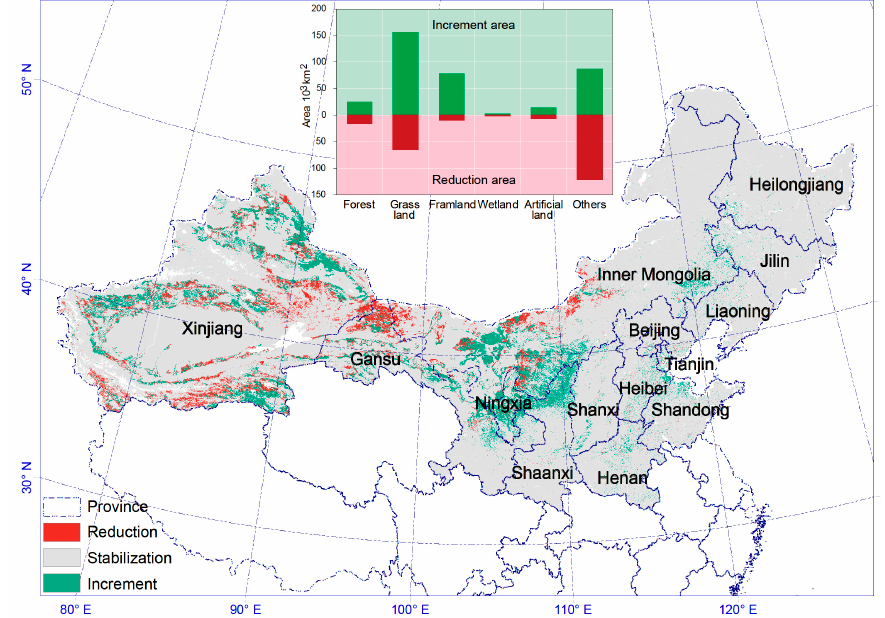
Figure 2. Changes in wind erosion prevention services from 2000 to 2015 in northern China (GCS: WGS84). Red shows areas where services have decreased, and green shows areas where services have increased. The subgraph illustrates the land use in the areas with reductions and increases.